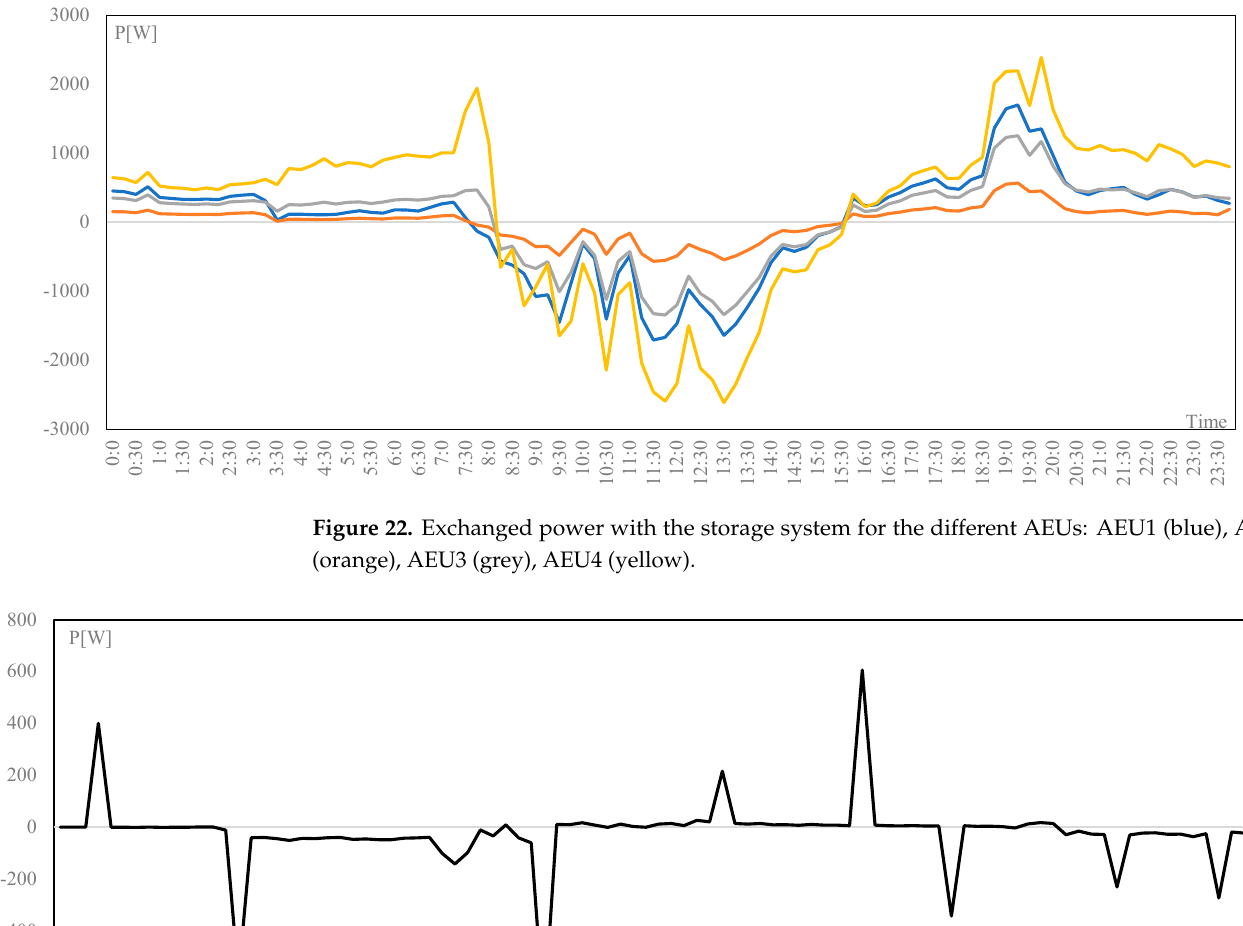
(grey), AEU4 (yellow).